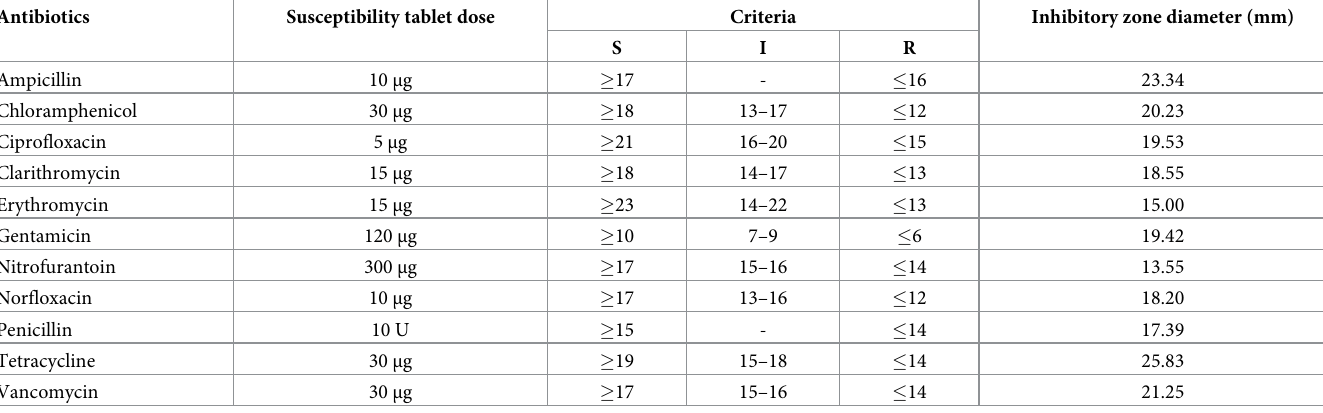
Observation of general health status revealed no noticeable behavioral or activity changes in the mice, and no treatment-related illness or death occurred. No differences in hair luster and feces were found between the experimental and control groups throughout the experiment. No viable bacteria from the livers, spleens, hearts, or kidneys of any mouse were successfully Table 3. Antibiotic resistance of E . thailandicus TC1.